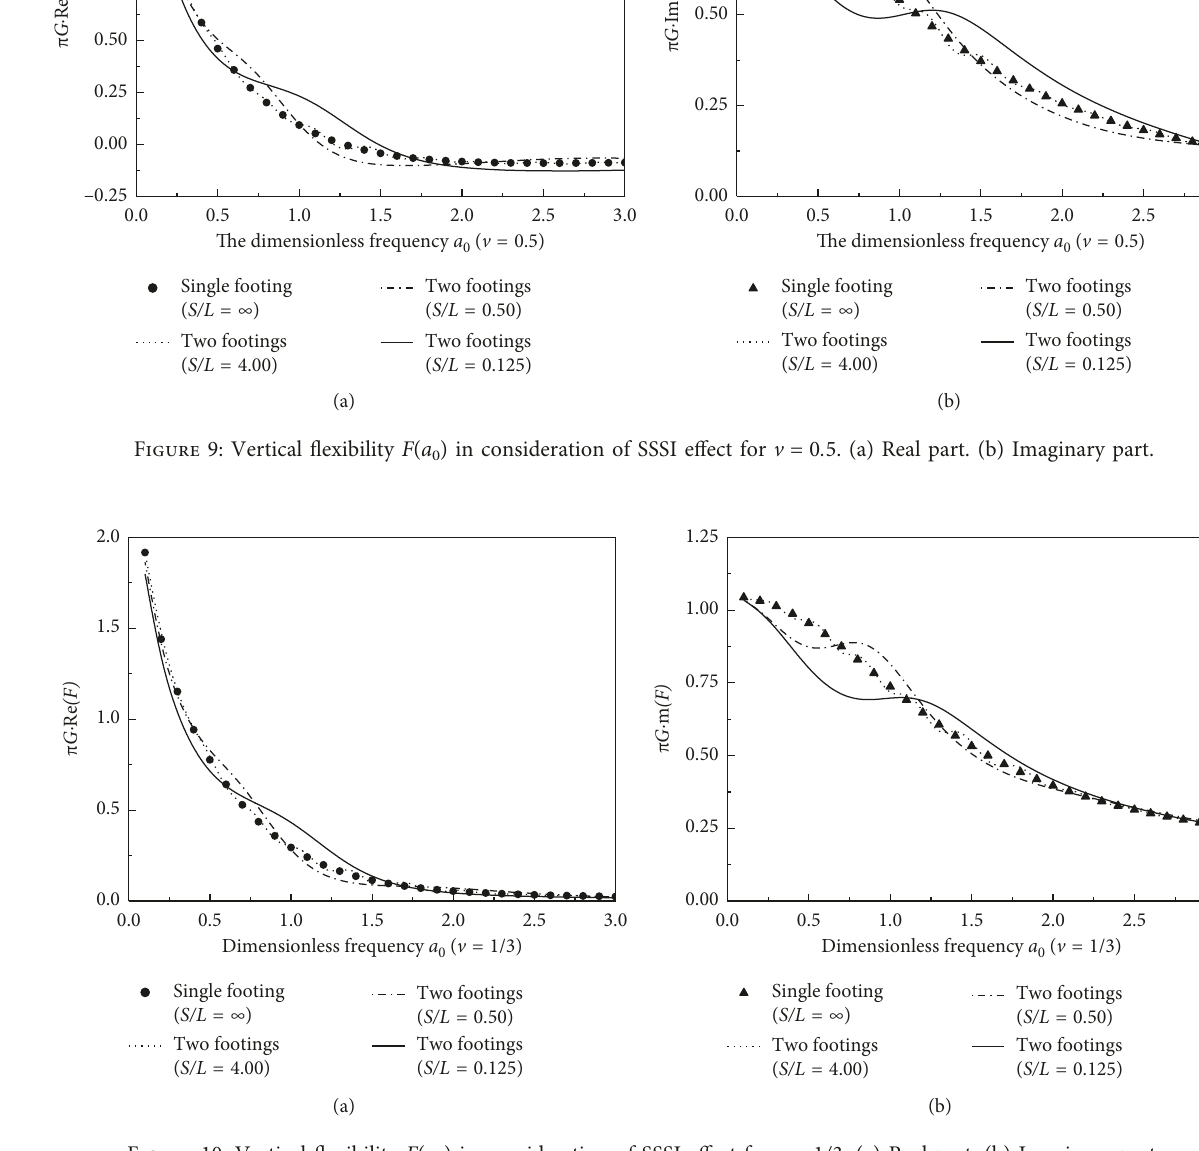
0 ) in consideration of SSSI effect for